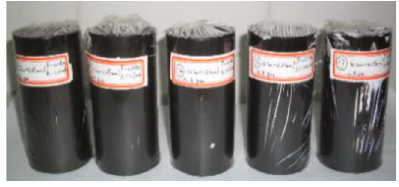
Figure 2: Part of briquette samples.